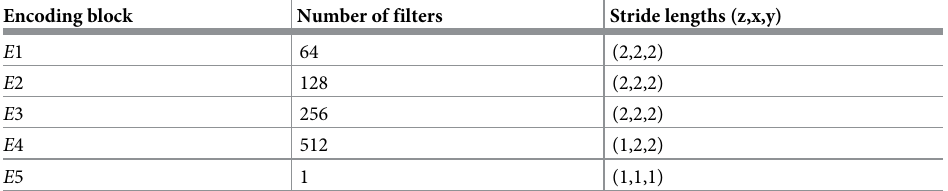
Table 3. The number of filters and stride lengths that were used in the three-dimensional Pix2Pix GAN’s discrimi- nator encoding